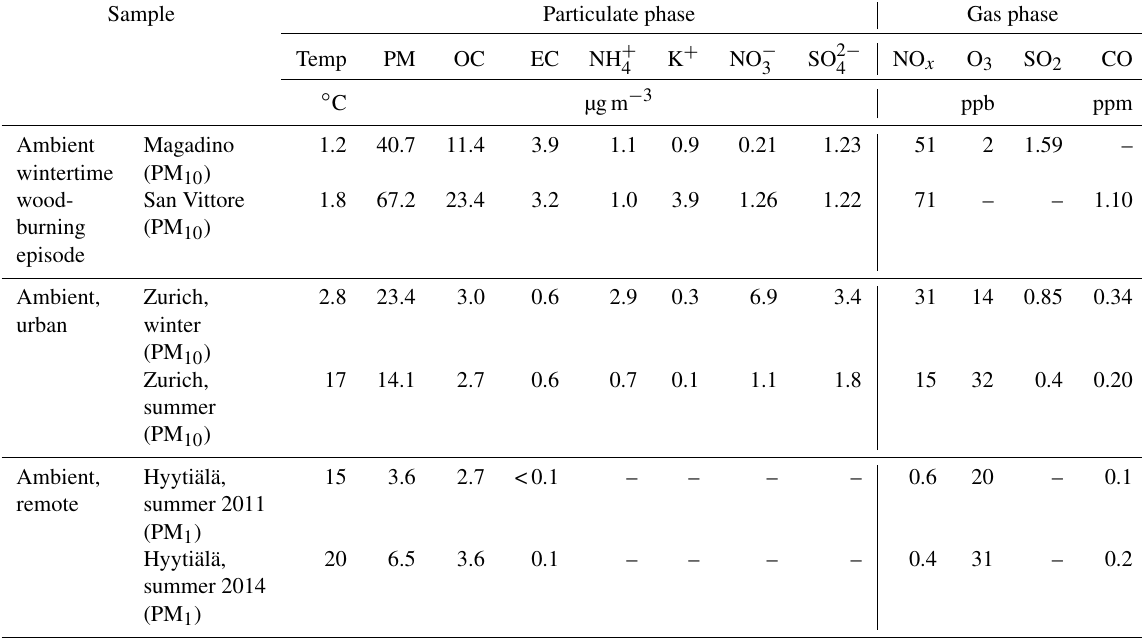
Table 1. Concentrations of particulate and gaseous species and temperature.